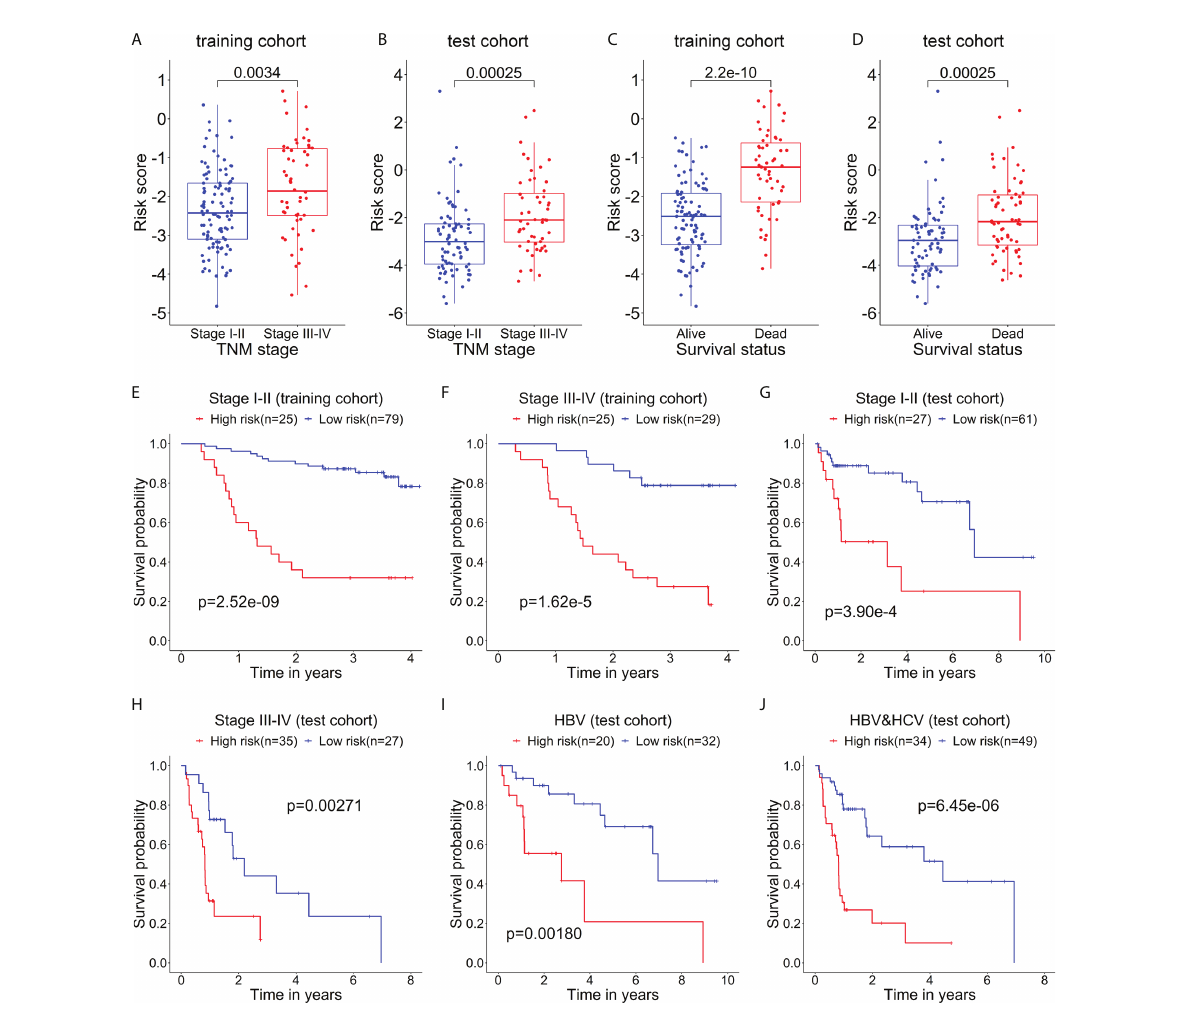
FIGURE 4 The relationship between the risk score and clinical characteristics of patients. The box plots show that the risk scores of patients with stage III- IV are signi fi cantly higher than those of patients with stage I-II in the training cohort (A) and test cohort (B) . The box plots show that the risk scores of dead patients are signi fi cantly higher than those of alive patients in the training cohort (C) and test cohort (D) . Kaplan – Meier curves show the difference in OS between the high- and low-risk groups in two subgroups of the training cohort, including Stage I-II (E) and Stage III- IV (F) . Kaplan – Meier curves show the difference in OS between the high- and low-risk groups in several subgroups of the test cohort, including Stage I-II (G) , Stage III-IV (H) , HBV (only HBV-positive) (I) , and HBV-HCV (both HBV- and HCV-positive) (J)